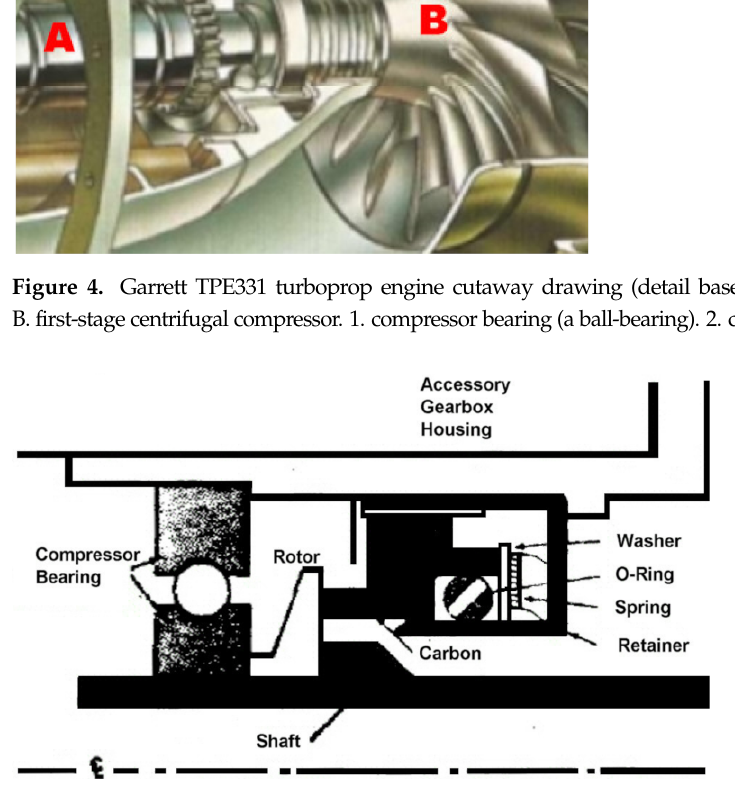
Figure 5. Mechanical (carbon) seal assembly next to the main shaft compressor bearing on the TPE331 engine (based on Figure 3 in